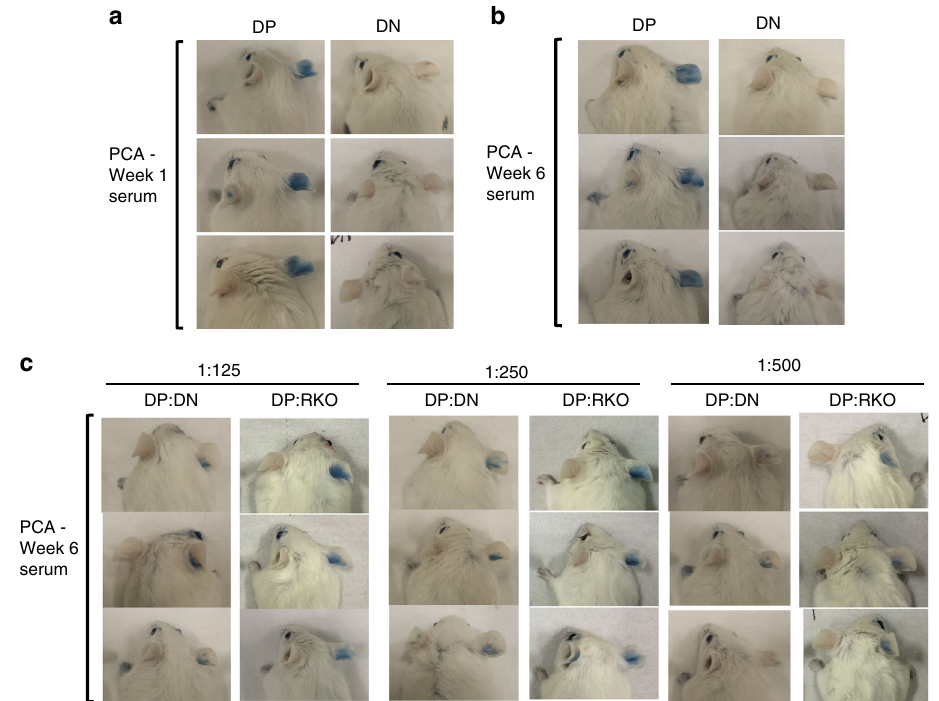
Fig. 7 IgE derived from DP MBC mediates anaphylaxis. The pathogenic capacity of IgE derived from DP and DN IgG1 MBC was evaluated in a passive cutaneous anaphylaxis (PCA) assay. IgG-depleted serum was obtained from Rag1 KO recipient mice that had been transfused with DP or DN IgG1 + MBC and CD4 memory T cells from primary OVA-PEP1 immunised TBmc mice as described in Fig. 2a, c, d. The recipient mice were immunised with OVA-PEP1, and serum was obtained at 1 and 6 weeks after transfer/immunisation. Serum from each group was pooled and depleted of IgG antibodies. For the PCA assay, 20 μ l of serum was injected intradermally into the ears of naive BALB/c mice. Twenty-four hours later, 50 µ g OVA-PEP1 and 1% Evans Blue in PBS were injected intravenously. Thirty minutes later, the anaphylactic reaction was evaluated visually. a , b Sera from recipients of DP IgG1 MBC (DP-serum), but not from recipients of DN IgG1 MBC (DN-serum), mediated anaphylaxis. a One-week sera. b Six-week sera. c To determine if the DN-serum could inhibit anaphylaxis, 6-week DP-serum was diluted with 6-week DN-serum, or with serum from untreated Rag1 KO mice (RKO serum) at the indicated DP:DN